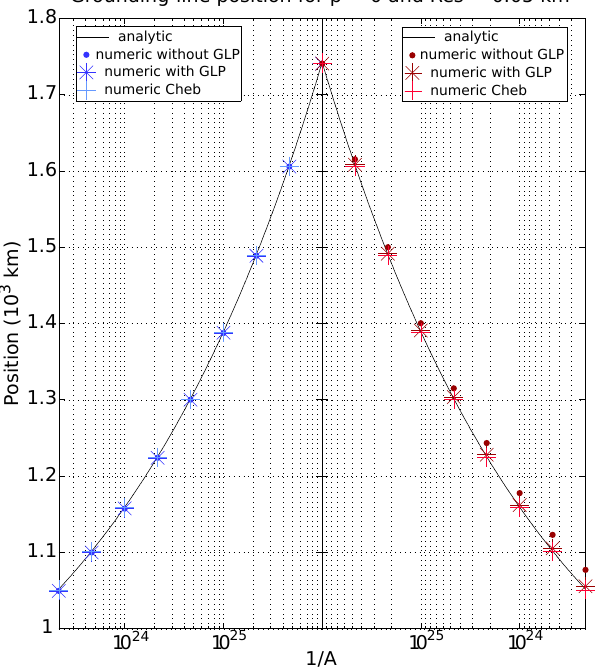
Figure 5. The grounding-line position during advance and retreat experiments over a linear bed at 50m resolution with p = 0 from the boundary-layer solution by Schoof (2007a) (solid black), the Chebyshev benchmark model (pluses), the fixed-grid model with- out the GLP (dots) and the fixed-grid model with the GLP (stars). The boundary-layer solution is in close agreement with the Cheby- shev benchmark (maximum difference of 1.2km), as are the fixed- grid results with or without the GLP. Both fixed-grid models closely agree with the Chebyshev benchmark during advance (maximum difference of 1.2km). During retreat, the model with the GLP matches the benchmark (maximum difference of 5km) better than the model without the GLP (maximum error of 26km).